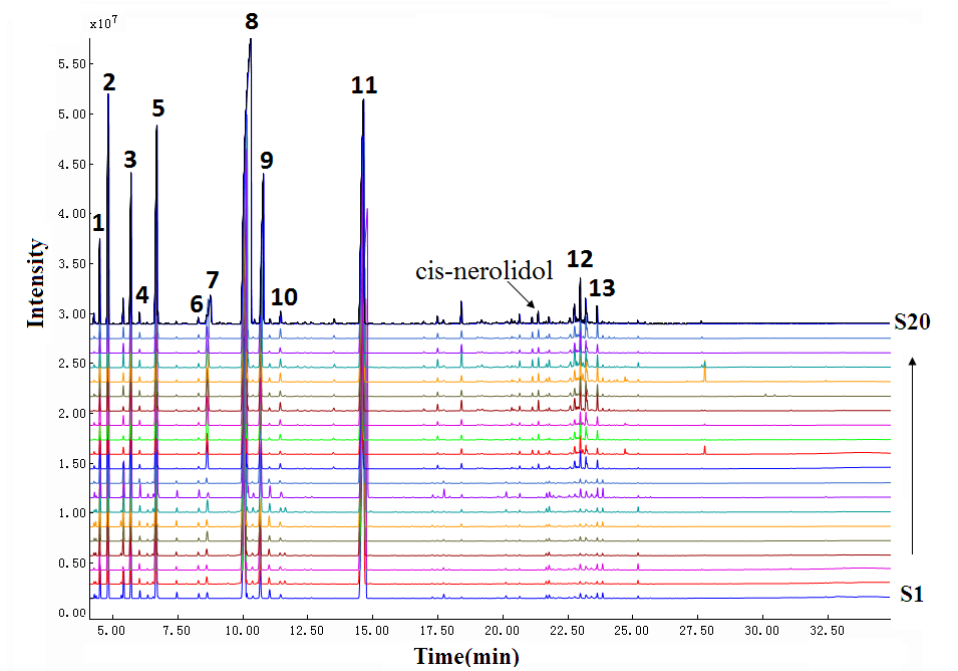
Figure 1. Gas chromatography – mass spectrometry (GC-MS) chromatogram of 20 batches of FA from two species.